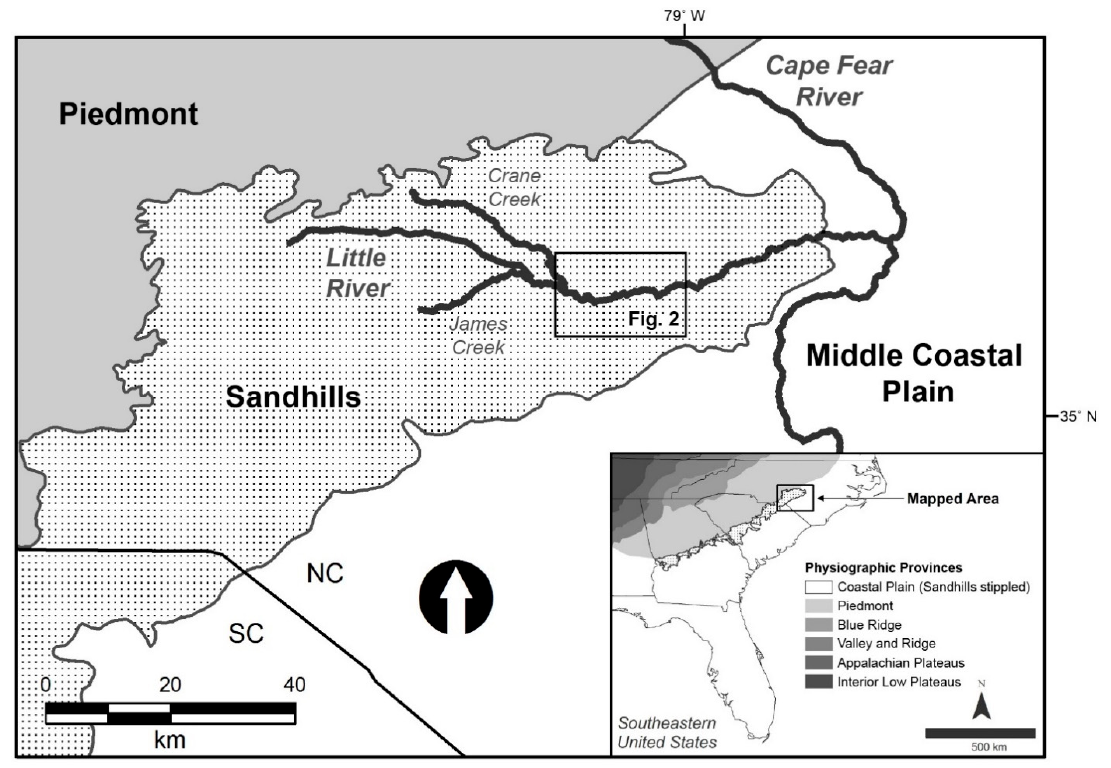
Figure 1. Study area in the Sandhills province of the upper Coastal Plain of North Carolina (main map) and within the southeastern United States (inset), modified from Figure 1 of Suther and Leigh [33]. The Little River and its major tributaries, as well as the location of Figure 2, are also shown. Reprinted from Geomorphology, 351, Suther, B.E., Leigh, D.S., Soil morphology of an alluvial chronosequence from the Little River, North Carolina Coastal Plain, USA (Article 106921), Pages 1–20, Copyright (2019), with permission from Elsevier.